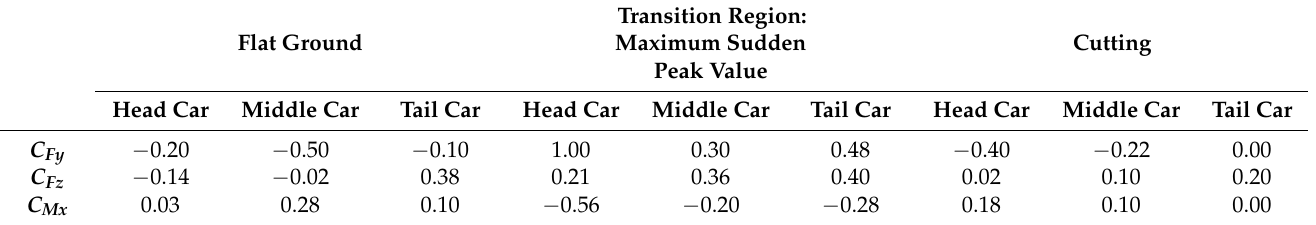
Table 3. Aerodynamic coefficient in different positions along the WT.